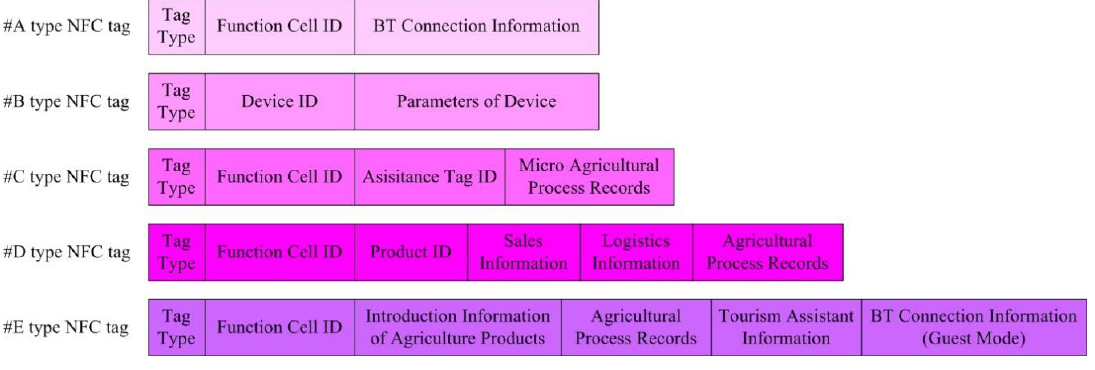
Figure 4. Information stored in NFC tags.